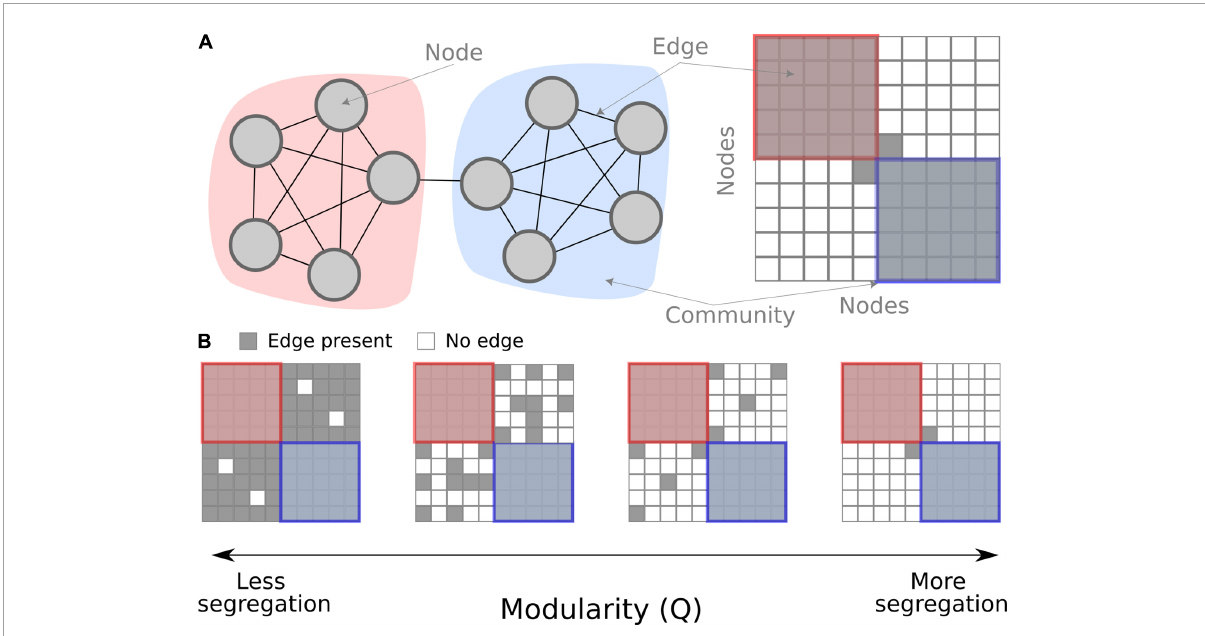
FIGURE1 Conceptual overview of modularity in a network. (A) A schematic network of 10 nodes in two communities (red and blue) connected by binary edges. On the left, the nodes are shown graphically, and on the right, the same schematic network is shown as a connectivity matrix. (B) Examples of modularity as a measure. When there are fewer between-community edges, the modularity measure is higher, interpreted as more